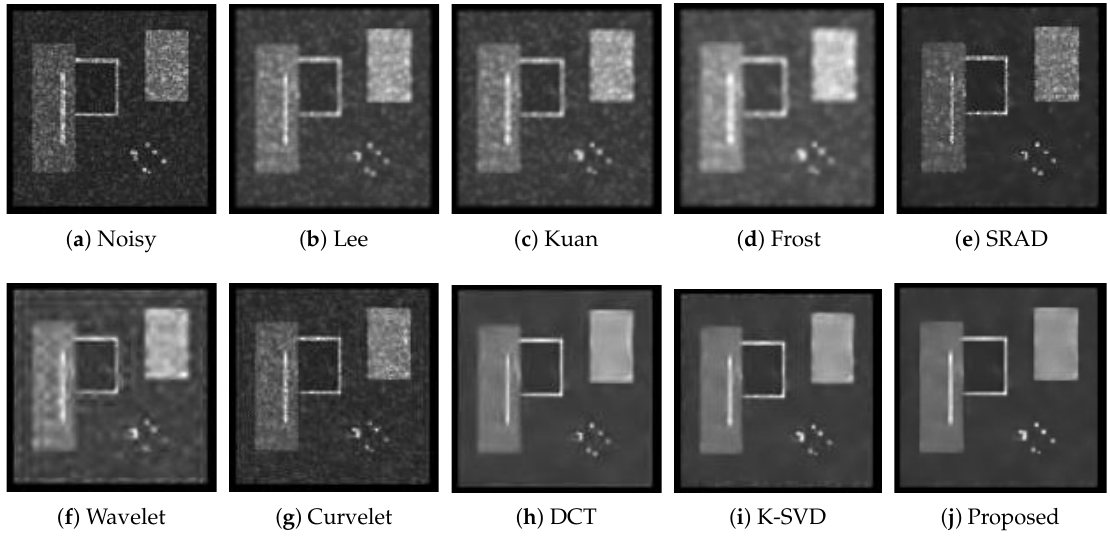
Figure 5. Denoising results of simulated noisy